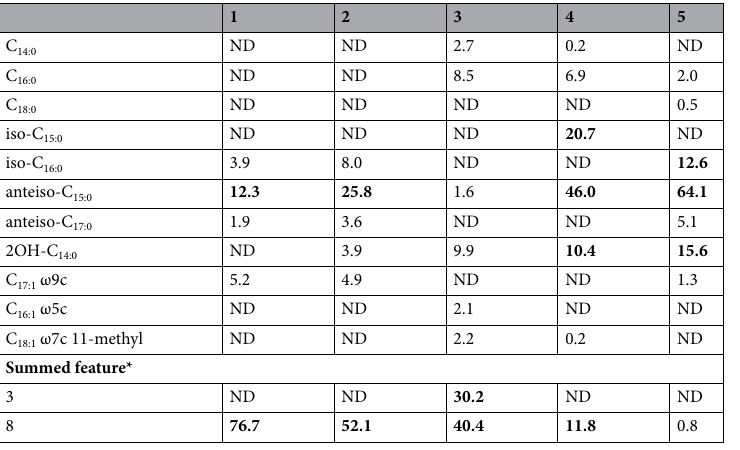
Table 2. Cellular fatty acid profiles (> 1%) of strain AK-R2A1-2 T and type strains of closely related species.